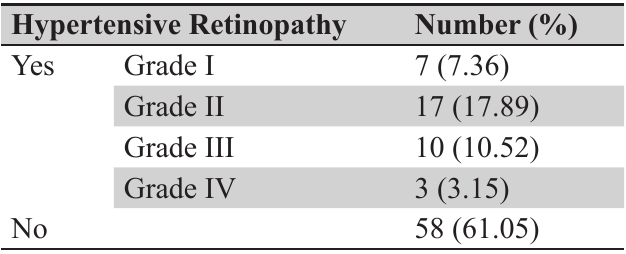
Table 1. Frequency of hypertensive